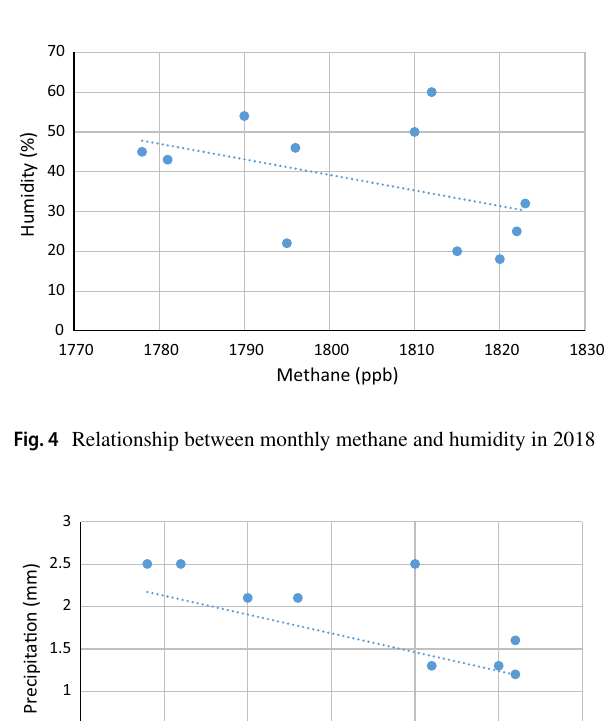
Fig. 6 Relationship between methane and NDVI in spring